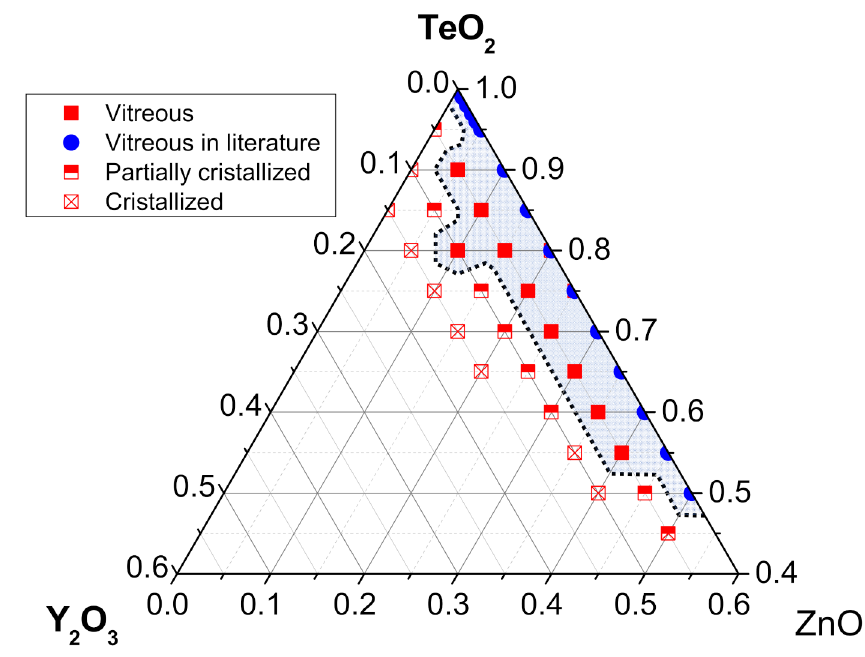
Figure 1. TeO 2 -ZnO-Y 2 O 3 ternary